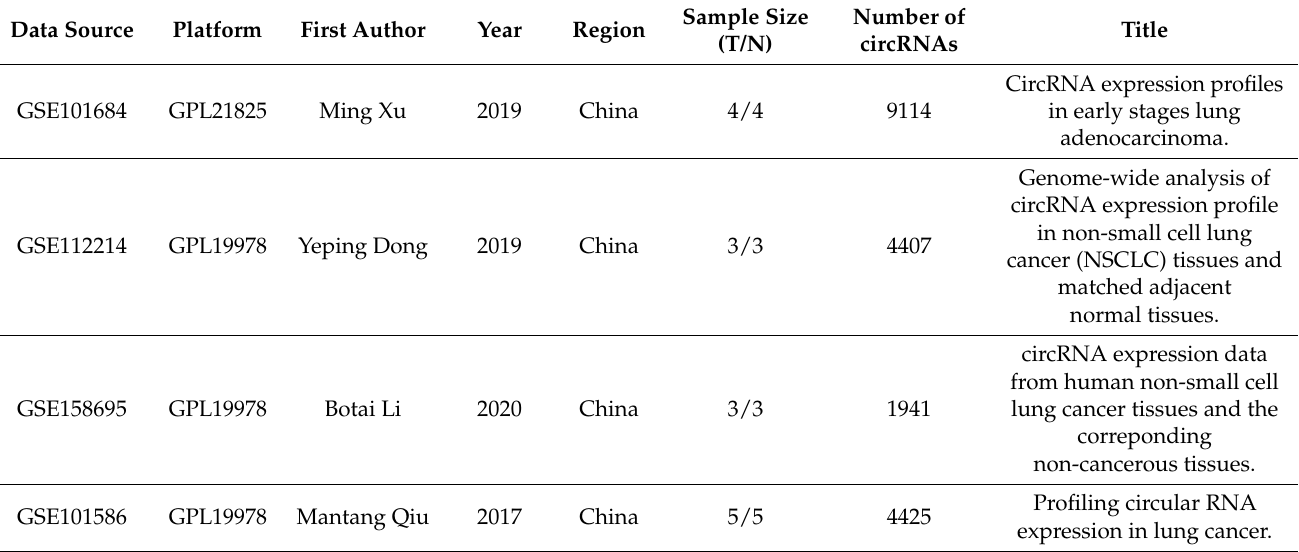
Table 1. Essential characteristics of the four GEO